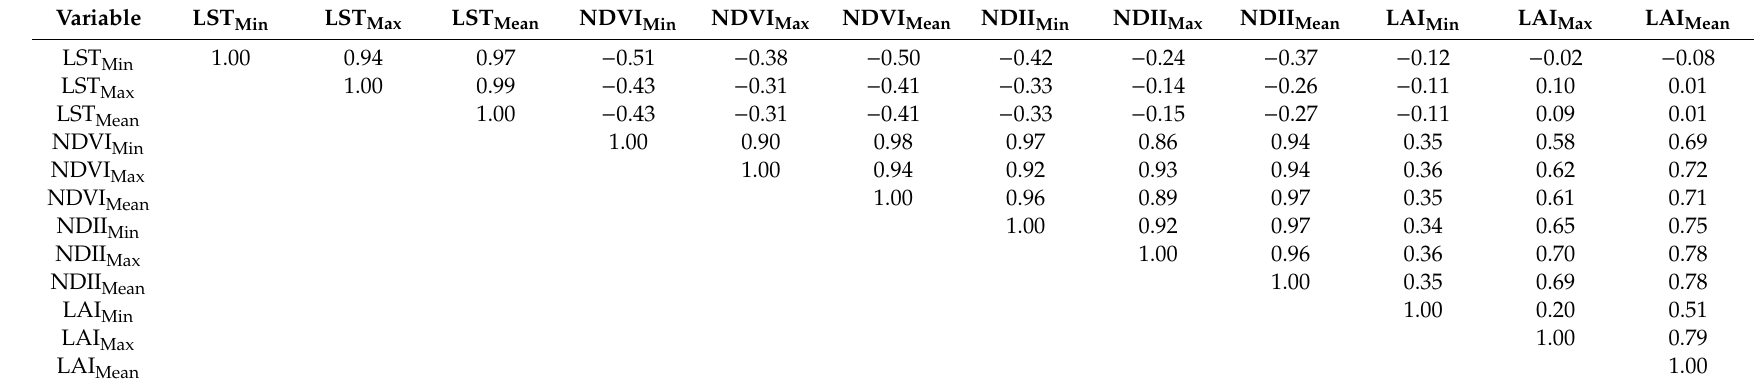
Table 3. Pearson (r) correlation statistics of the minimum, maximum, and mean values of LAI, LST, NDII, and NDVI at an annual scale. The LST minimum values showed relatively stronger correlation with minimum values of LAI, NDII, and NDVI compared to the maximum and mean values. Variable LST Min LST Max LST Mean NDVI Min NDVI Max NDVI Mean NDII Min NDII Max NDII Mean LAI Min LAI Max LAI Mean LST Min 1.00